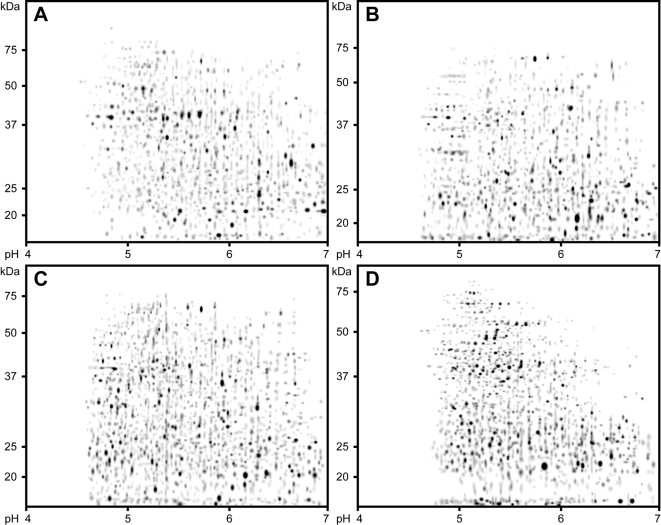
Representative 2D-PAGE separations of proteins extracted from (A) the EBPR28 sludge, (B) the EBPR42 sludge, (C) the EBPR55 sludge and (D) the nEBPR70 sludge.Approximate protein molecular mass ranges are provided on the left and isoelectric point ranges are provided on the bottom of the gel images.